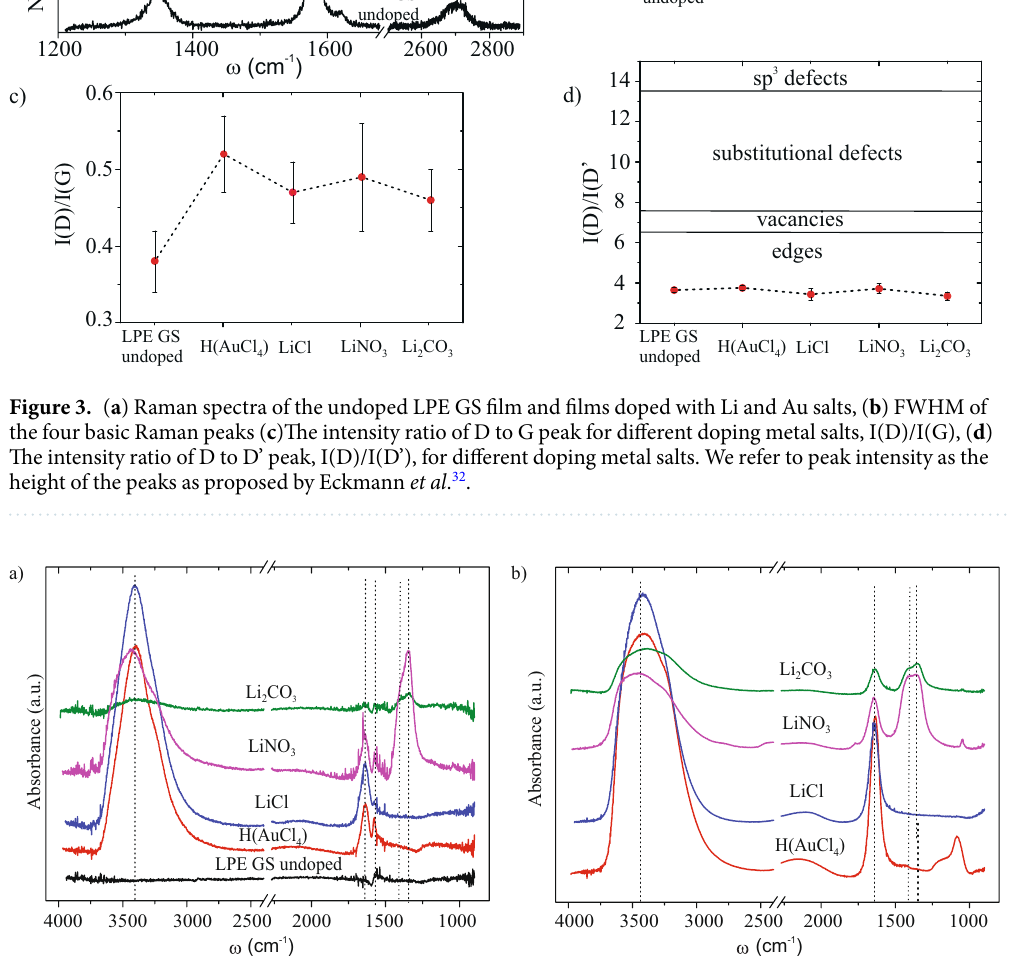
Figure 4. FT-IR spectra of ( a ) undoped and H(AuCl 4 ), LiCl, LiNO 3 , Li 2 CO 3 LPE GS doped films, ( b ) metal standard solutions (0.1 mg/mL) used for doping